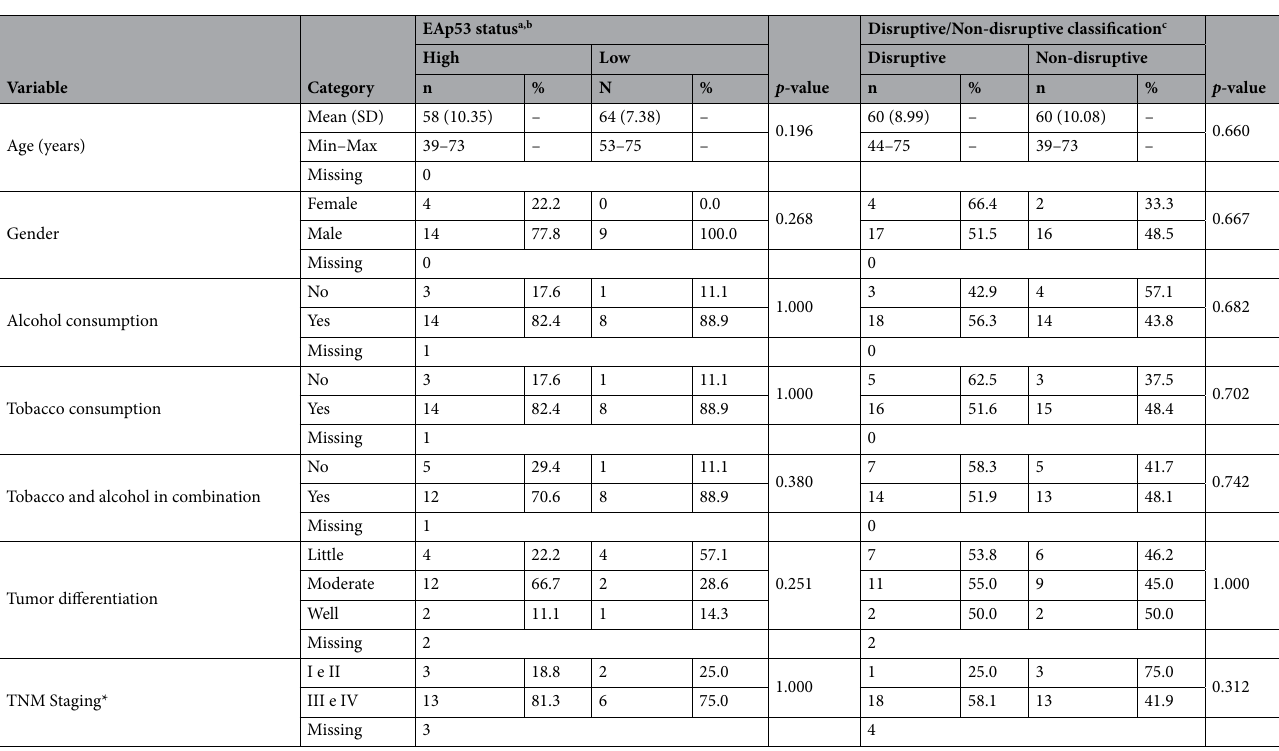
Table 4. Association between patients’ clinicopathological features with the classification of TP53 mutations. *TNM 7 edition staging; n – number of cases. a http:// mammo th. bcm. tmc. edu/ cgi- bin/ panos/ EAp53. cgi. b Neskey et al. Evolutionary Action Score of TP53 Identifies High-Risk Mutations Associated with Decreased Survival and Increased Distant Metastases in Head and Neck Cancer, Cancer Res. 2015 Apr 1;75(7):1527–36. n number of variants. c Poeta et al. TP53 mutations and survival in squamous-cell carcinoma of the head and neck. N Engl J Med 357, 2552–2561, https:// doi. org/ 10. 1056/ NEJMo a0737 70 (2007).